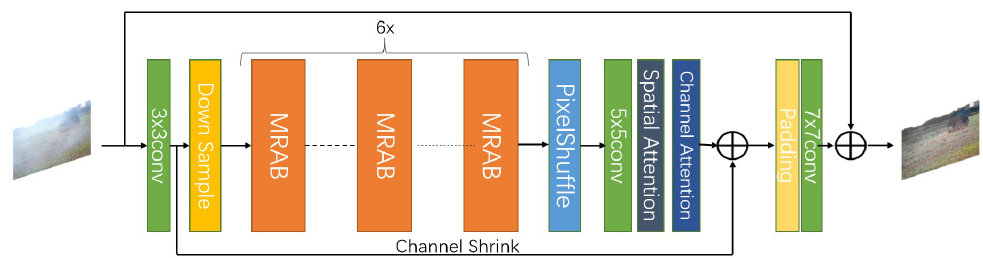
Figure 2. The efficient RRA-Net architecture. It cascades 6 MRABs, followed by a long skip connection with attention and a fusion